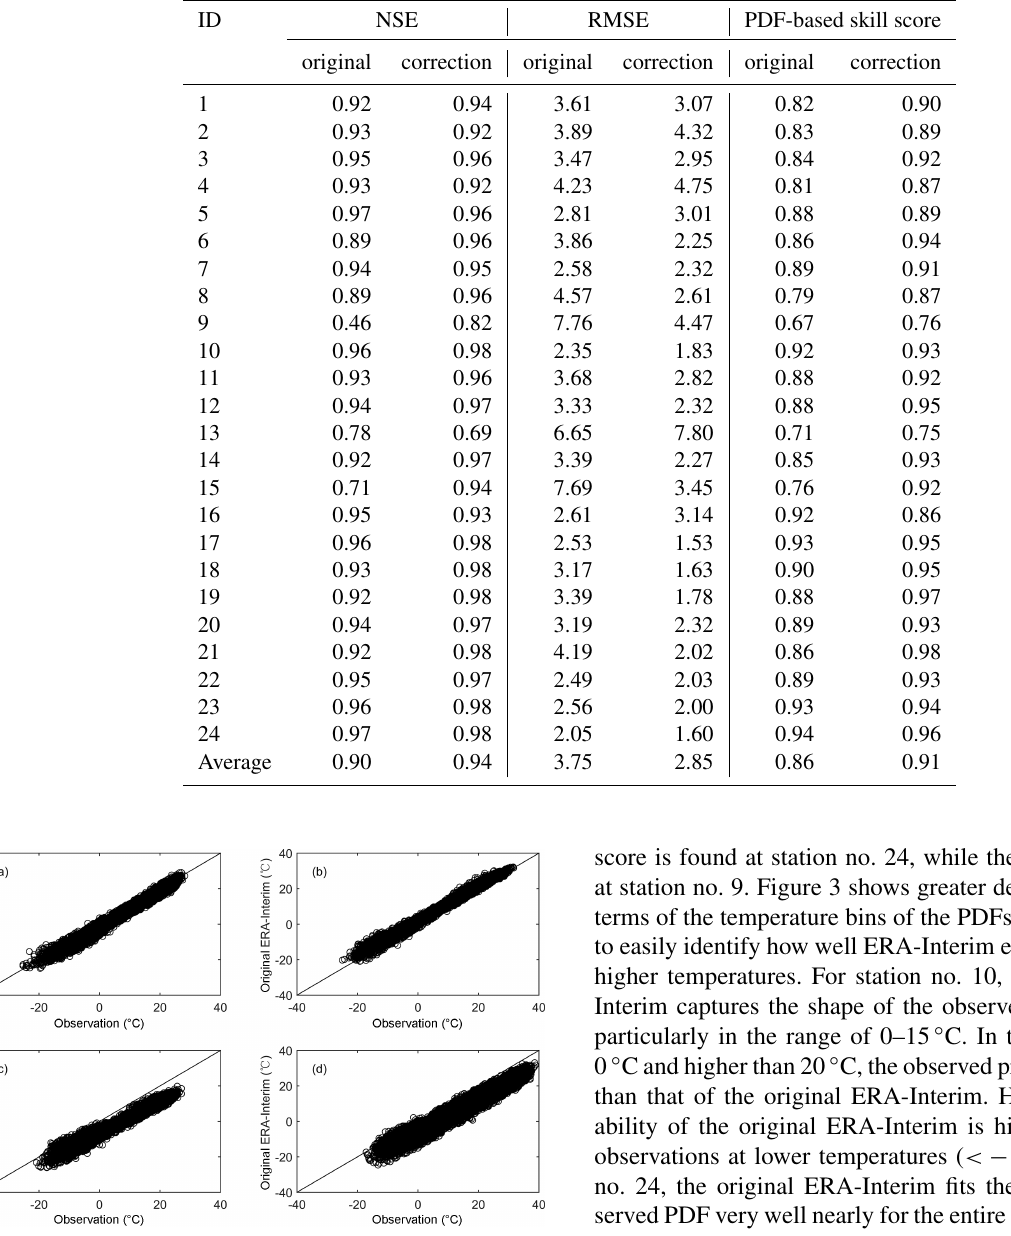
Figure 2. Scatter plots of observation and original ERA-Interim temperature data for (a) station no. 10, (b) station no. 24, (c) station no. 9, and (d) station no. 15. The corresponding RMSEs can be found in Table